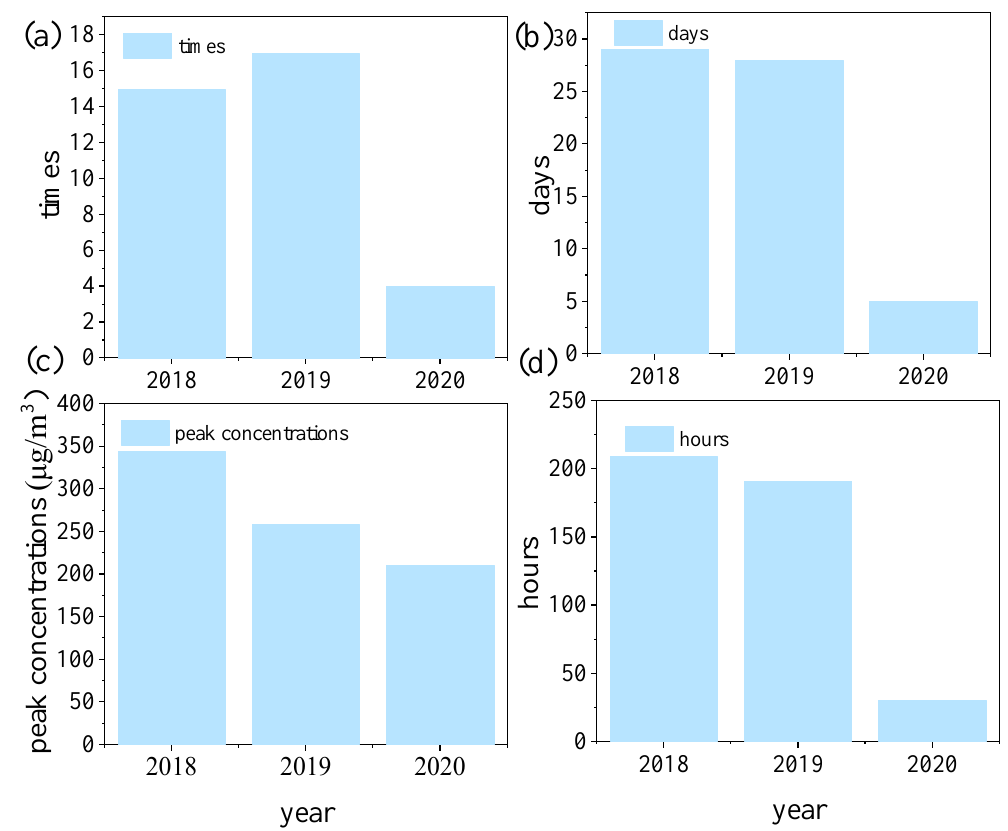
Figure 2. The frequency ( a ), the number of days ( b ), the hourly peak concentrations ( c ) and the total hours of O 3 episodes with an hourly value greater than 160 μg/m 3 ( d ) of O 3 episodes in different years. The average value of NO 2 were 25, 19, and 15 ppbv during O 3 episodes in 2018, 2019 and 2020, respectively, showing a decreasing trend. From the diurnal variation of pollu- tants during O 3 episodes (Figure 3), we can see that CO and SO 2 in 2020 were 1.7 ppbv and 3.3 ppbv, respectively, which is significantly higher than previous years.